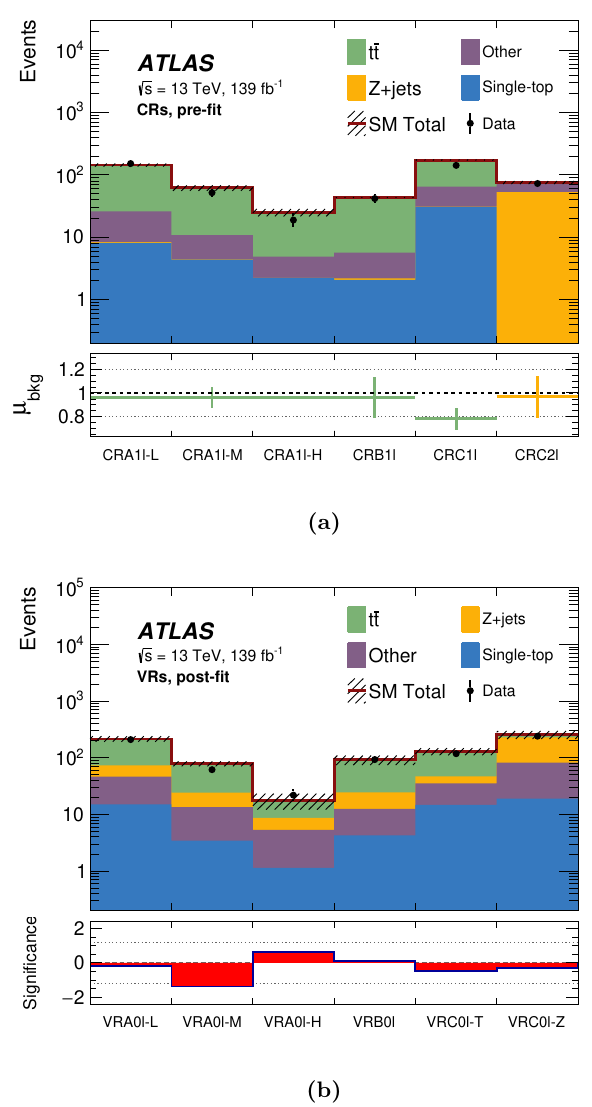
Figure 5. (a) Control region event pre-(cid:12)t event yields compared with SM MC predictions (top) and post-(cid:12)t (cid:22) scale factors (bottom) for the A-, B- and C-type regions. The uncertainty in the (cid:22) factors and the total expected yield include statistical and systematic uncertainties as introduced in section 7. For the A-type regions, since the (cid:12)t is performed in the m e(cid:11) intervals, the normalisation is applied to all bins equally. (b) Results of the background-only (cid:12)t extrapolated to VRs for the A-, B- and C-type regions. The normalisation of the backgrounds is obtained from the (cid:12)t to the CRs. The upper panel shows the observed number of events and the predicted background yields. Statistical and systematic uncertainties as introduced in section 7 are included in the uncertainty band. The lower panel shows the signi(cid:12)cance in each VR. The signi(cid:12)cance calculation is performed as described in ref. [91]. The minor backgrounds (diboson, W +jets and t (cid:22) t + W=Z=h ) are grouped and labelled as